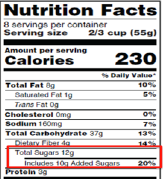
US dietary guidelines and food labeling